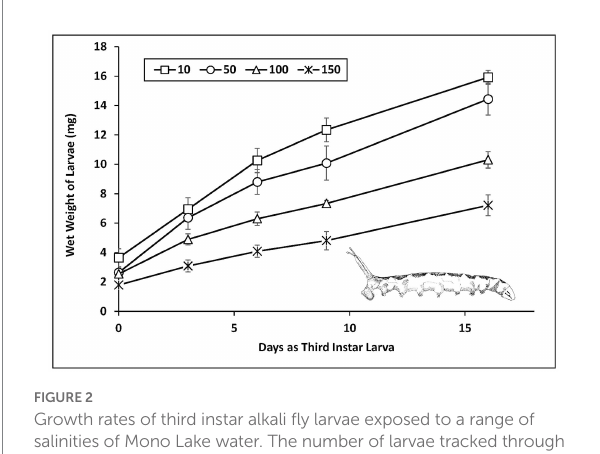
FIGURE 2 Growth rates of third instar alkali fly larvae exposed to a range of salinities of Mono Lake water. The number of larvae tracked through the 16 th day of weighing trials were 12, 6, 7 and 4 at 10, 50, 100 and 150 g L − 1 (standard error for each data point).